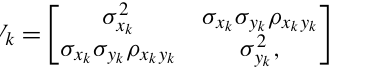
√ mswd Age Age ± (cid:49) Move